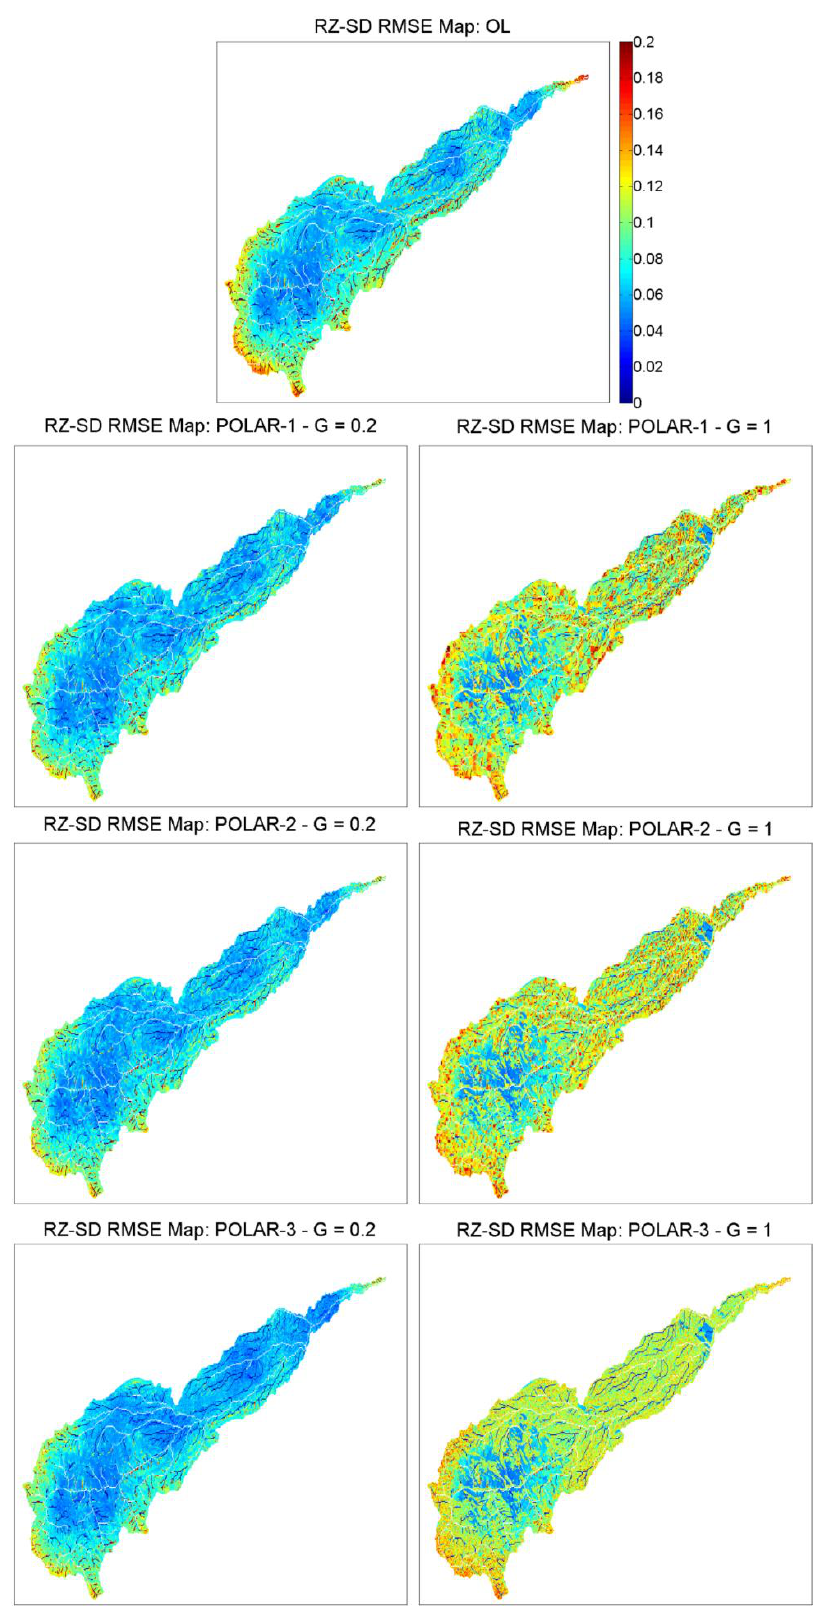
Figure 13. Comparison of RMSE maps generated by the OL run and the ones generated by assimilating POLAR SAR-like SM products, with G values equal to 0.2 and 1.